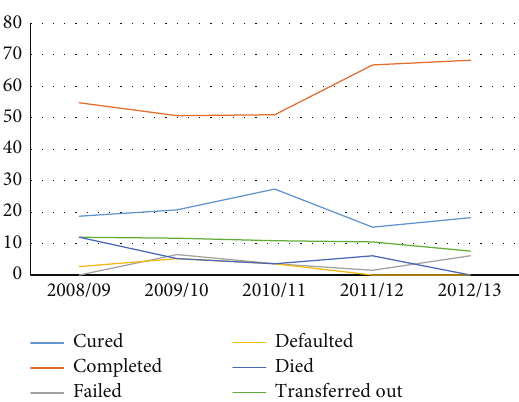
Figure 2: Trends of treatment outcomes of TB over the course of five years at Debre Tabor Health